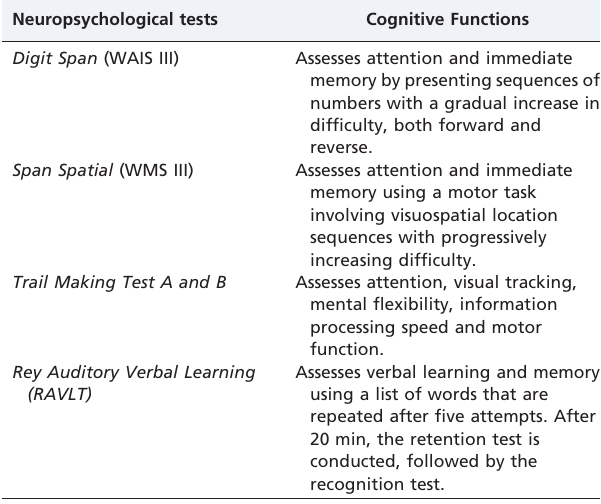
Table 1 - Neuropsychological tests and functions.